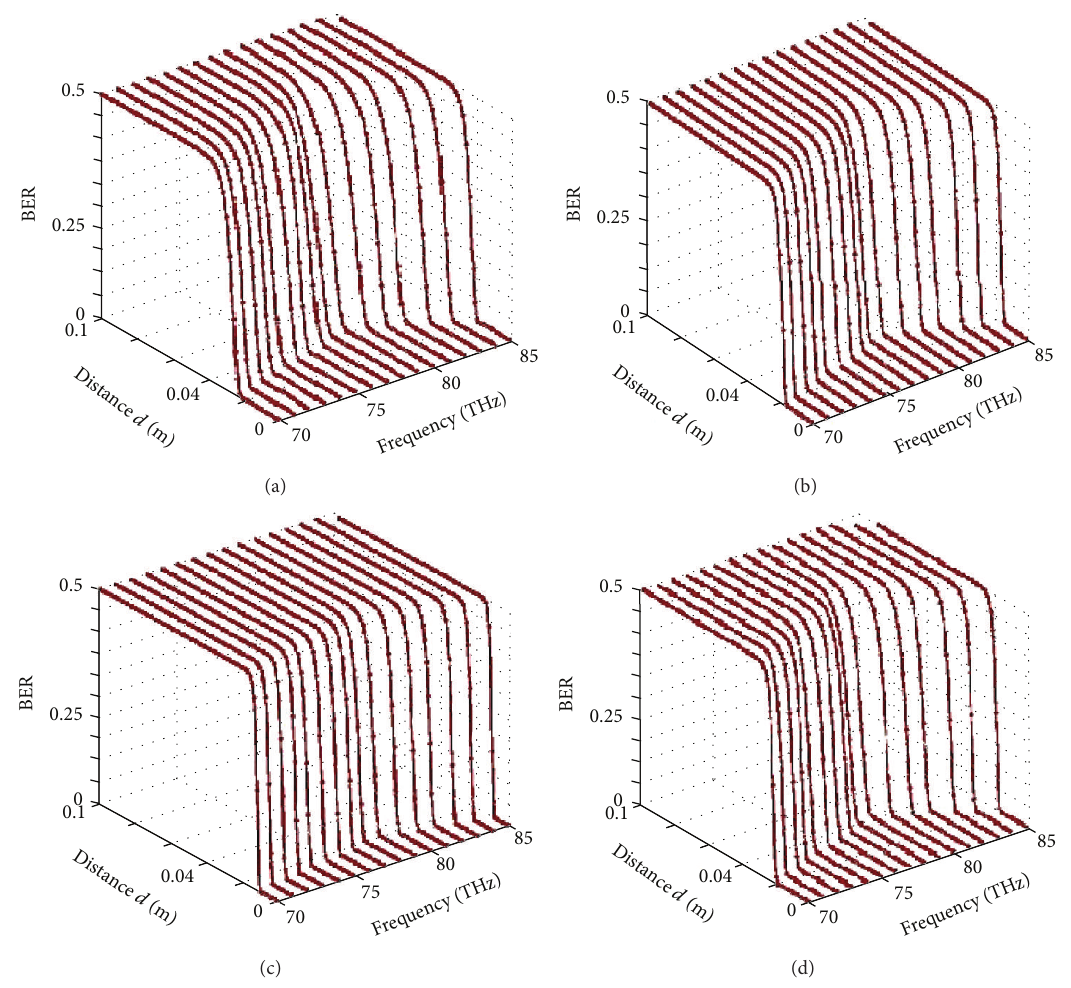
Figure 11: BER versus operating frequency and transmission distance for mixtures (a), (b), (c), and (d) with 10dBm transmit power.